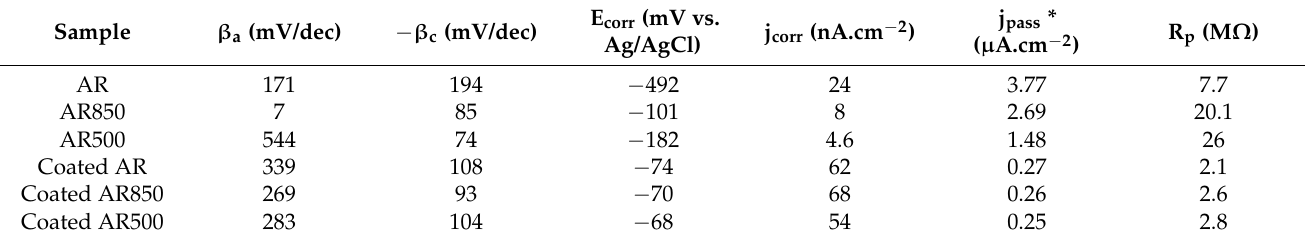
Table 6. Representative electrochemical parameters derived from the respective polarization curves of the samples.